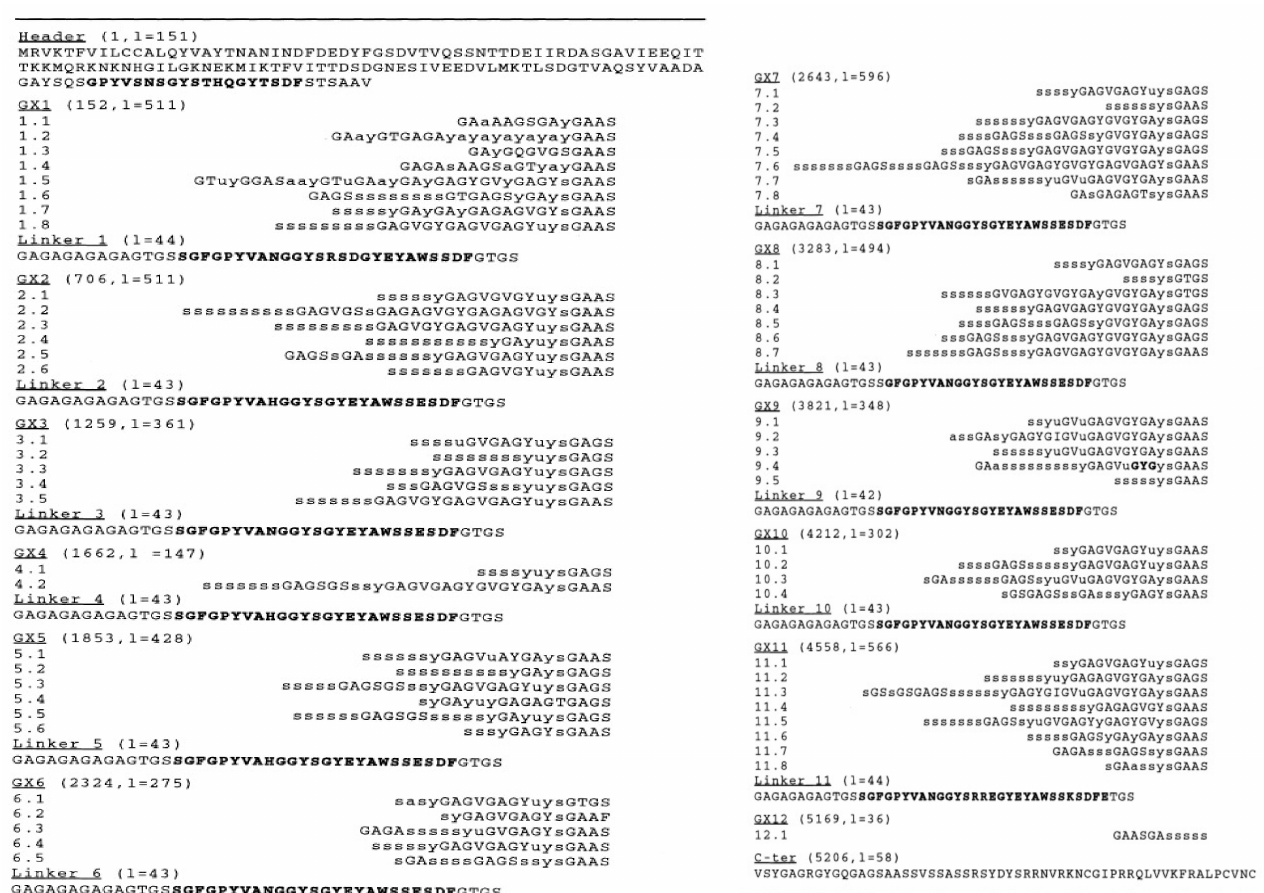
Figure 1. The primary structure of B. mori silk fibroin (H chain) was reported by Zhou et al. [13,14]. The 5263-amino acid residue chain is broken into domains and subdomains. The sequence number of the first residue and the length l of each domain are given in parentheses. The 25-residue motif in boldface characters is repeated between the header and the linkers. A one-residue (or three-residue) insertion in subdomain GX9.4 is also in boldface characters. Lower case letters s, y, a, and u represent frequently observed hexapeptides. Hexapeptides code and a number of copies; s, GAGAGS 433; y, GAGAGY 120; a, GAGAGA 27; u, GAGYGA 39. Reprinted with permission from ref. 14. Copyright 2001 John Wiley and